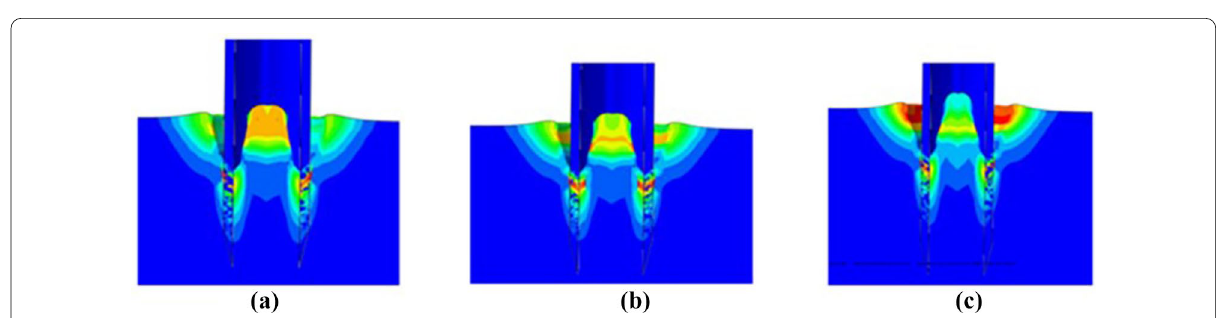
Figure 13 Simulation results of tissue deformation with different needle diameters